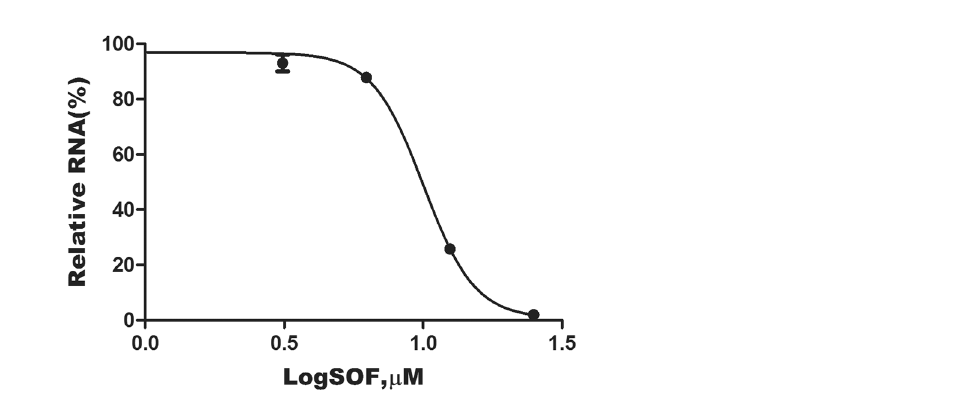
Figure 2. Dose-response curve showing inhibition of DENV RNA production by SOF. The inhibitory effect of SOF on viral RNA levels was determined by qRT-PCR assay. Relative levels of viral RNA were calculated as a percentage of levels in untreated control cells. The data shown are from experiments run in duplicate. The mean of EC 50 values and standard deviation (SD) determined from the results of three independent experiments was 9.9 ± 1.2 µ